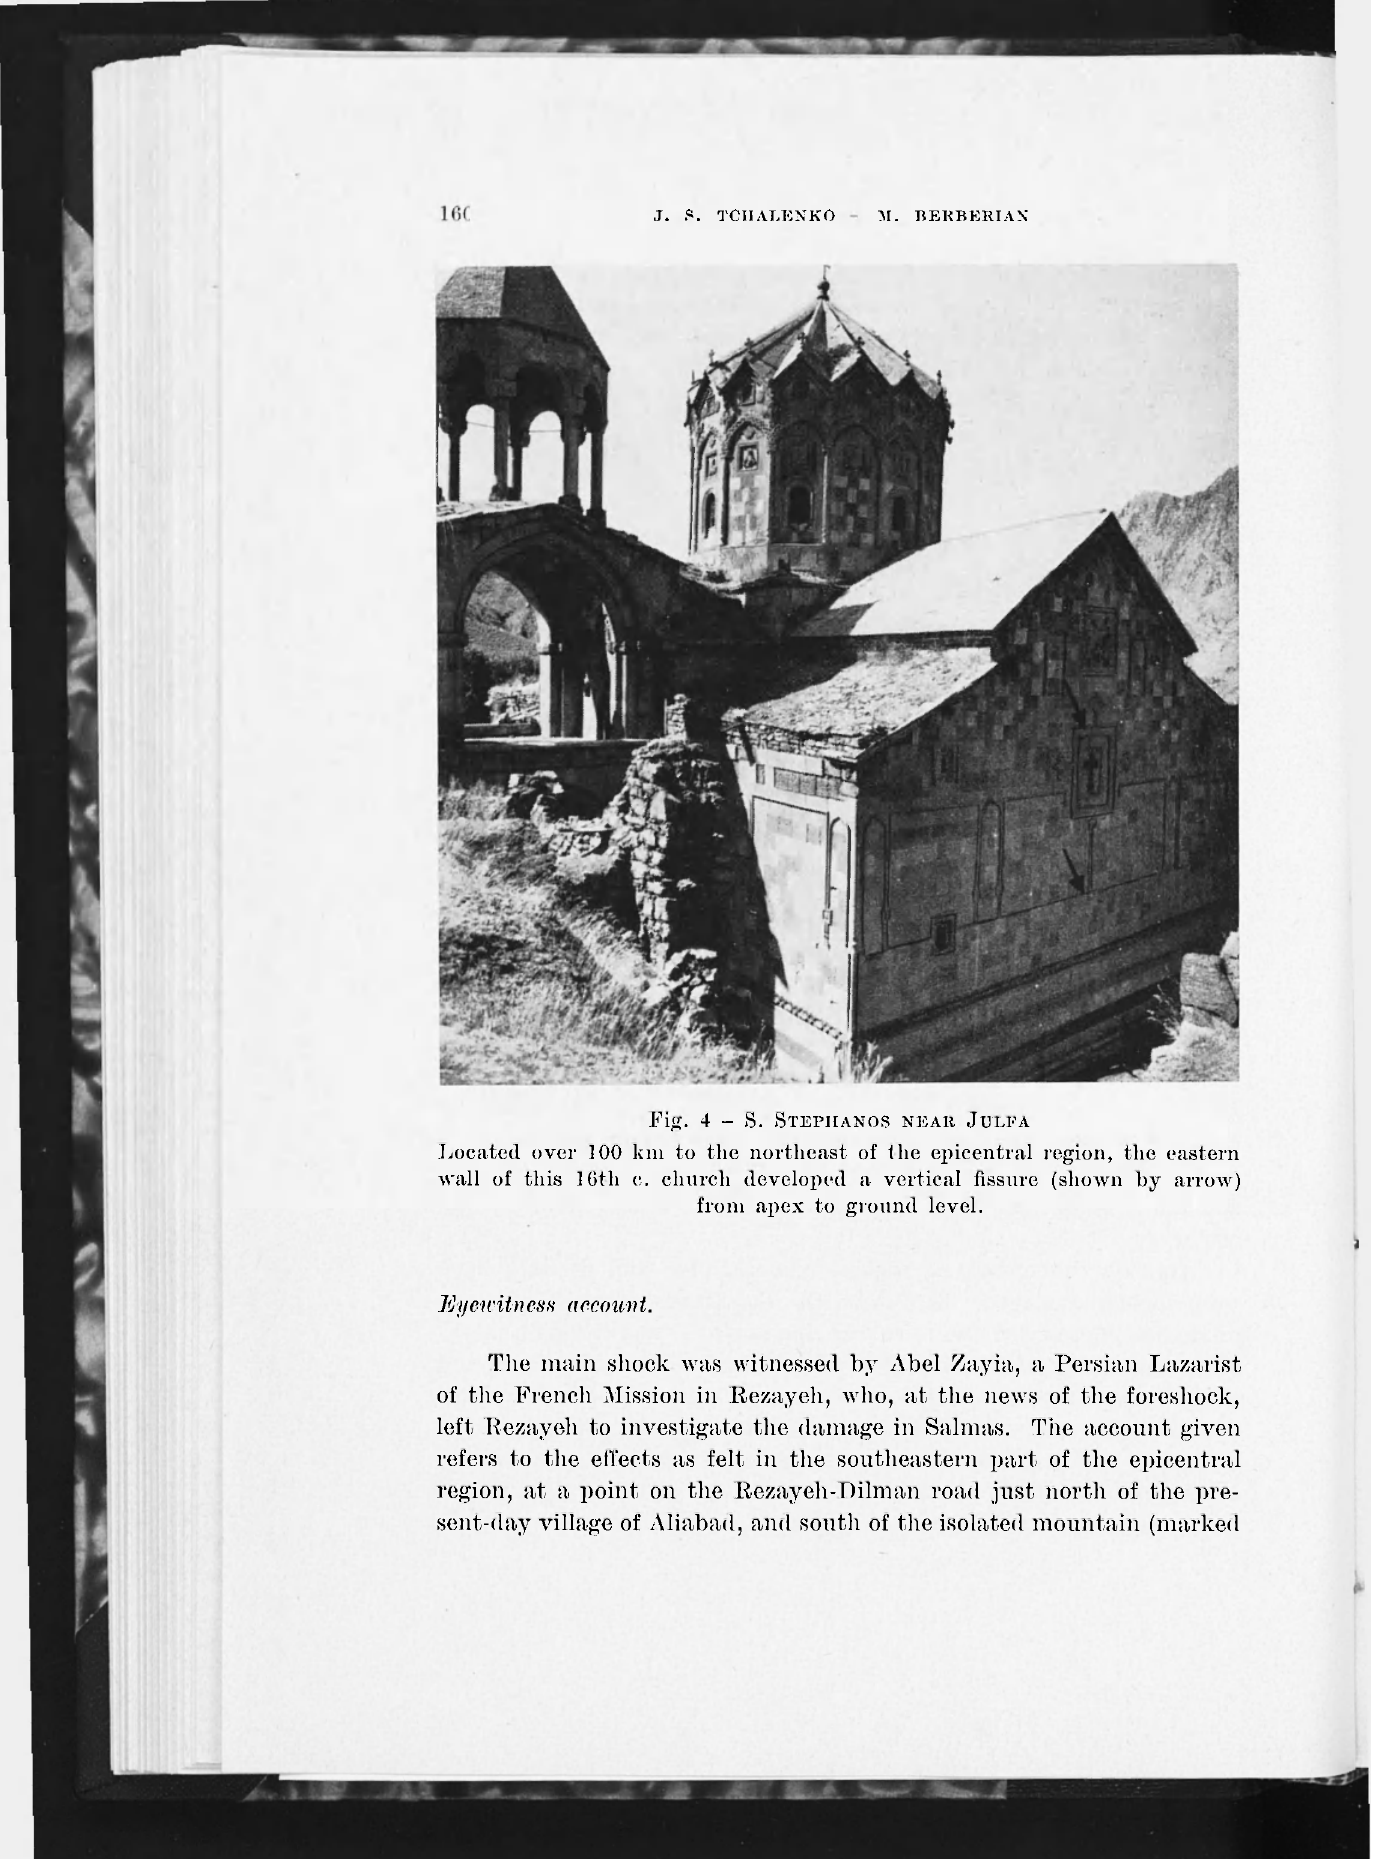
Fig. 4 - S. STEPHANOS NEAR